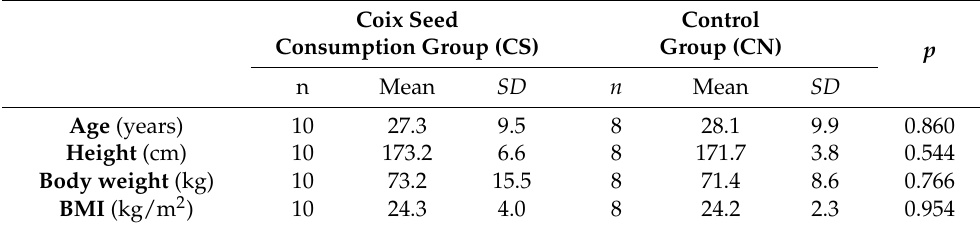
Figure 1. Diagrammatic synopsis of the participants’ enrollment and allocation, as well as of the analysis phase of the study. Table 1. Synopsis of the age and the anthropometric characteristics of the study’s participants, as assigned to the two groups.